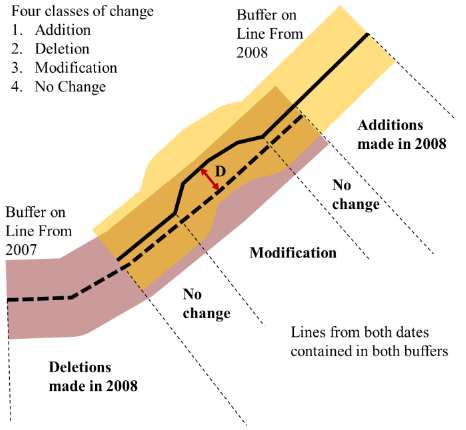
Figure 2 The determination of change in line geometry (e.g., roads) between two dates.